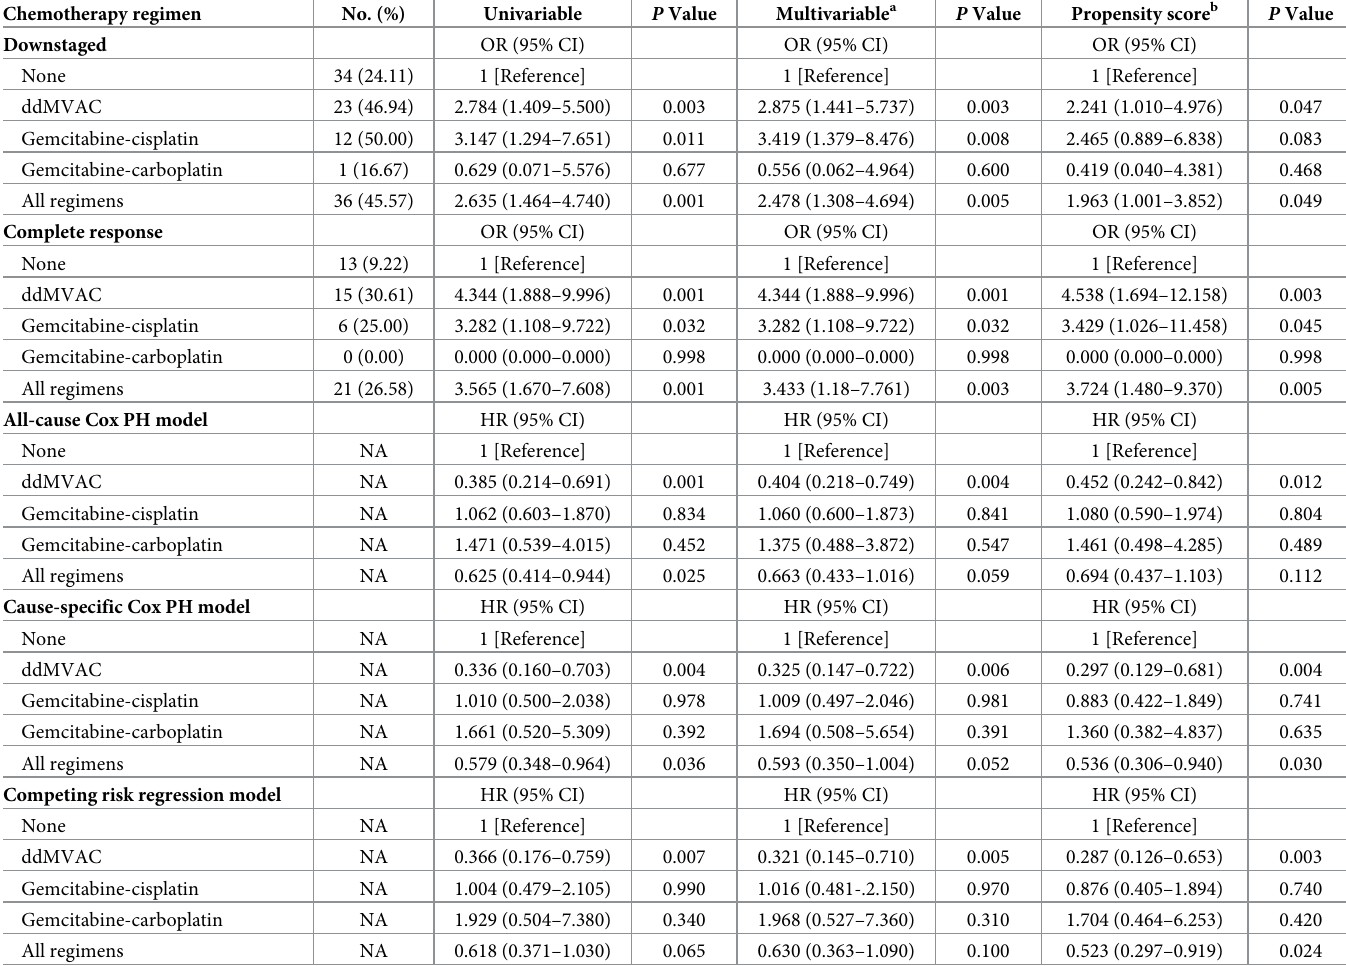
Table 2. Univariable, multivariable and Propensity-Weighted Regression analysis of factors predicting downstaging ( < pT2N0), complete (pT0N0) pathological response and survival outcomes. Chemotherapy